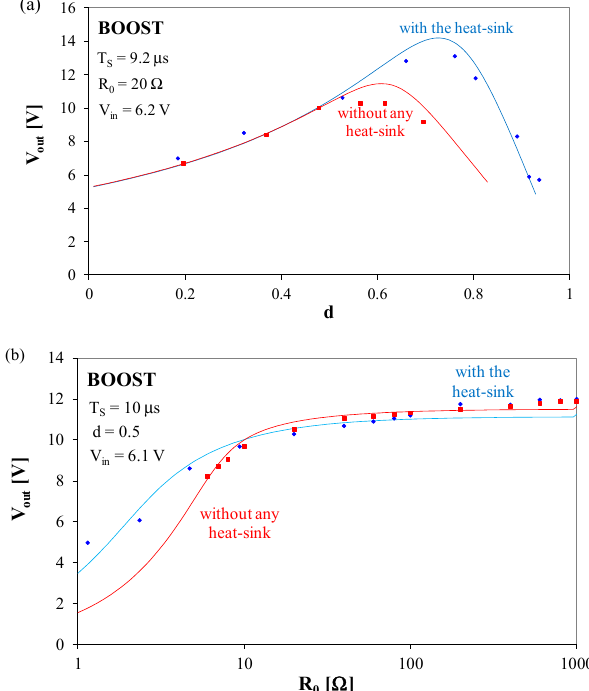
Figure 4. Dependences of the boost converter output voltage on: ( a ) the duty cycle d, ( b ) on load resistance.